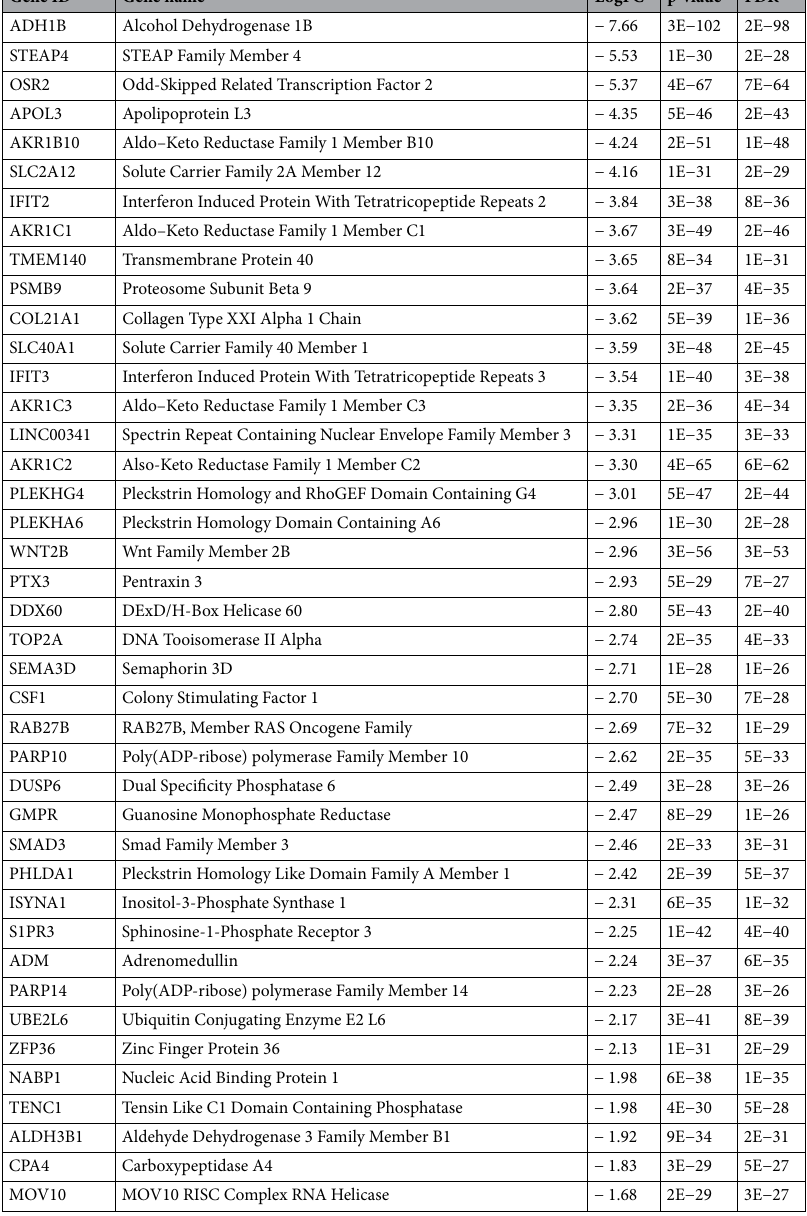
Table 2. Top 50 down-regulated